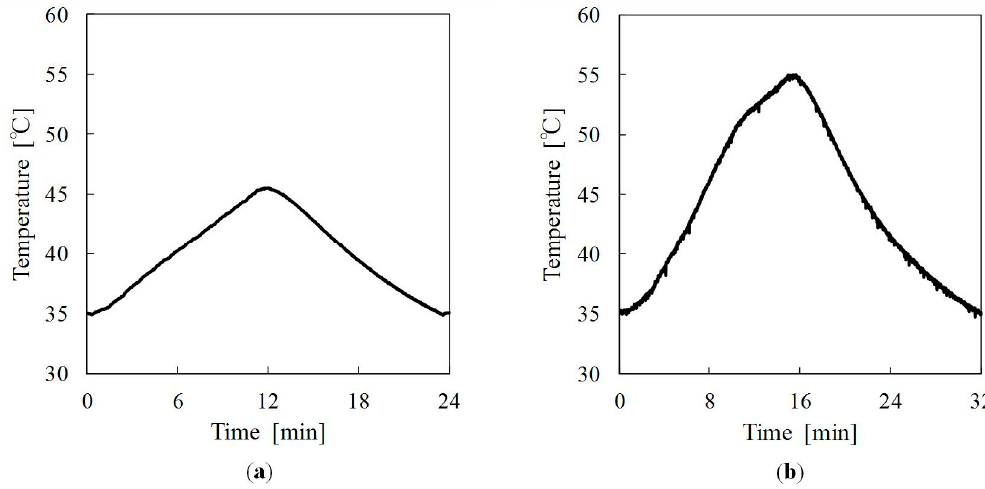
Figure 2. Surface temperature of green composite during one thermal cycling: ( a ) 35–45 °C; ( b ) 35–55 °C.